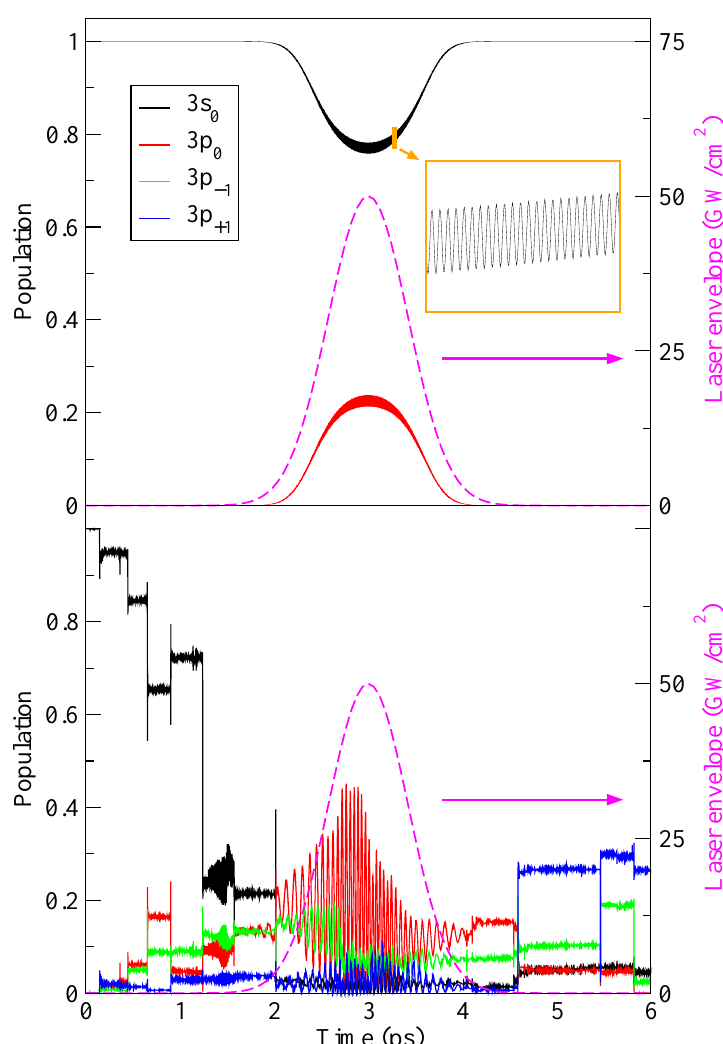
Figure 4. Time-dependent populations (i.e., the diagonal density-matrix elements) of the OI 3 s and 3 p states under influence of a picosecond, λ = 800nm laser pulse (upper panel) and under joint action of the same laser pulse and a plasma with n e = 10 18 cm − 3 and T e = 1eV (lower panel). The laser envelope is shown by the dashed line. The quantization axis is parallel to the electric field of the